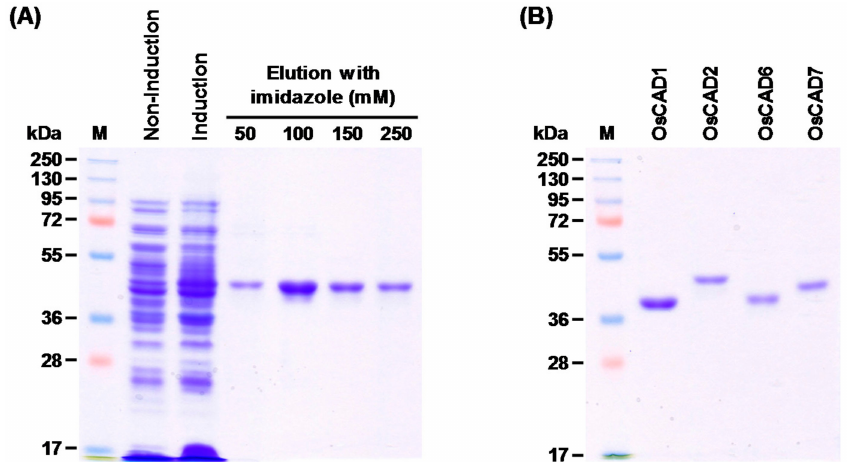
Figure 3. Purification of recombinant OsCADs expressed in E. coli . The His-tagged OsCAD1, 2, 6 and 7 were expressed in E. coli in a soluble form. The recombinant proteins were purified by Ni 2+ -affinity chromatography. ( A ) Representative purification of the recombinant OsCAD2 protein. ( B ) Affinity purified recombinant OsCAD proteins. M, Molecular weight marker.